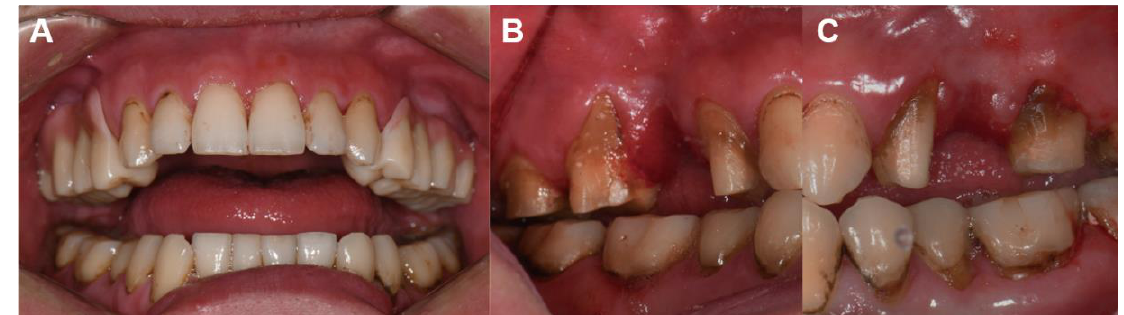
Figure 4. 1-year follow-up data. ( A ), Definitive restorations of fixed prosthesis with denture flange. ( B , C ), Oral tissue and periodontal maintenance are clinically acceptable.